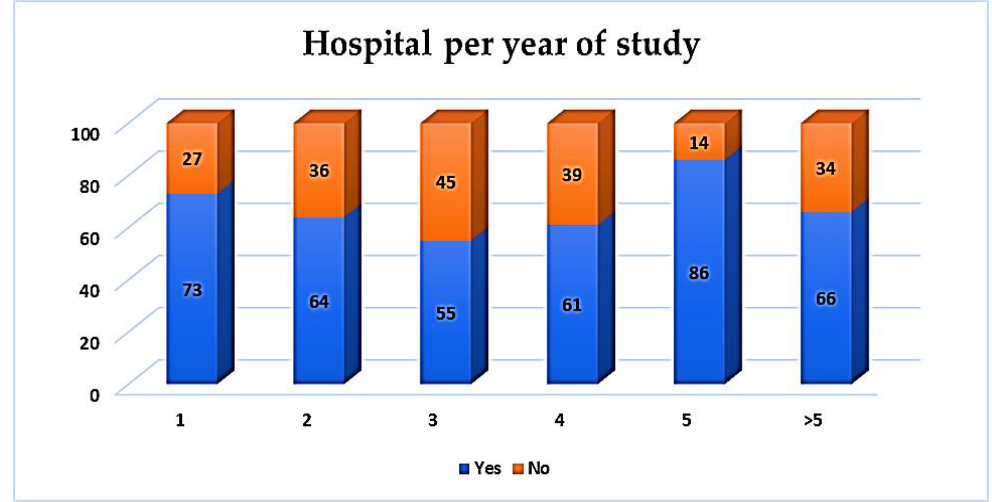
Figure 20. BS perceived integration to services — hospital per year of study .